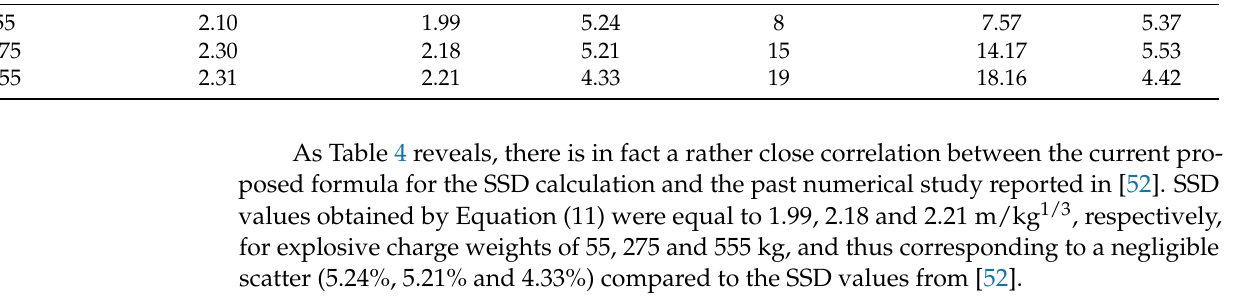
Table 4. Verification results of the proposed formula, with respect to previous study [52] .